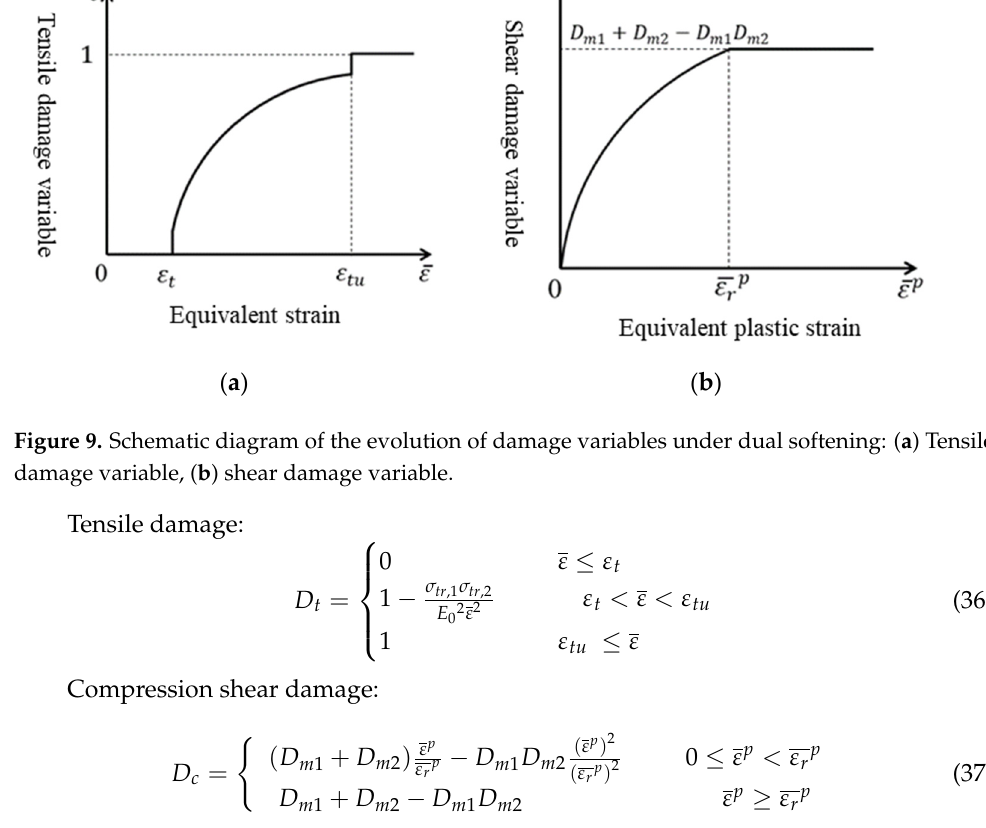
( b ) Figure 8. Schematic diagram of the evolution of unloading softening damage variables: ( a ) Tensile damage variable, ( b ) shear damage variable.